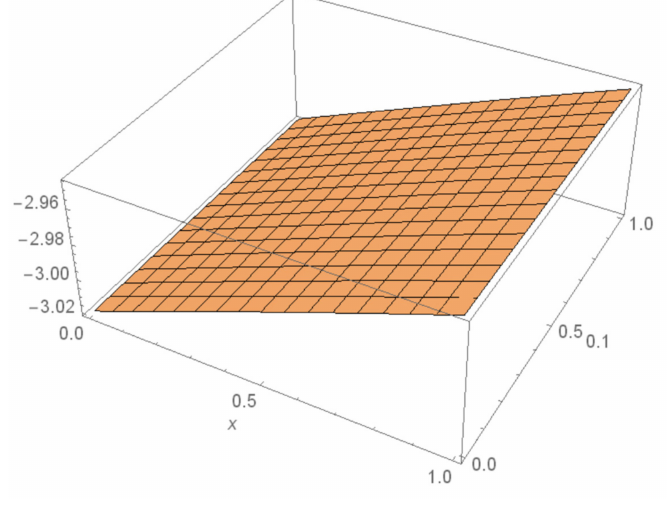
Figure 3. 3D plot of (cid:101) g ( η , t ) .